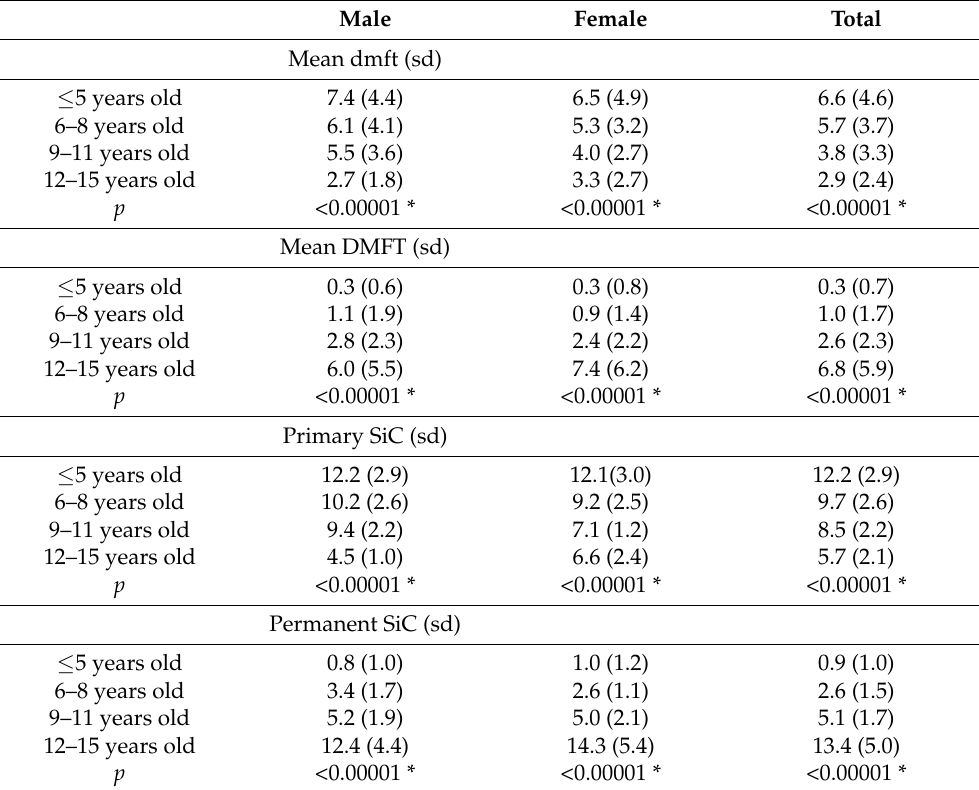
Figure 2. Distribution of DMFT according to the tooth type. Table 2. Distribution of mean dmft/DMFT and SiC index among different study